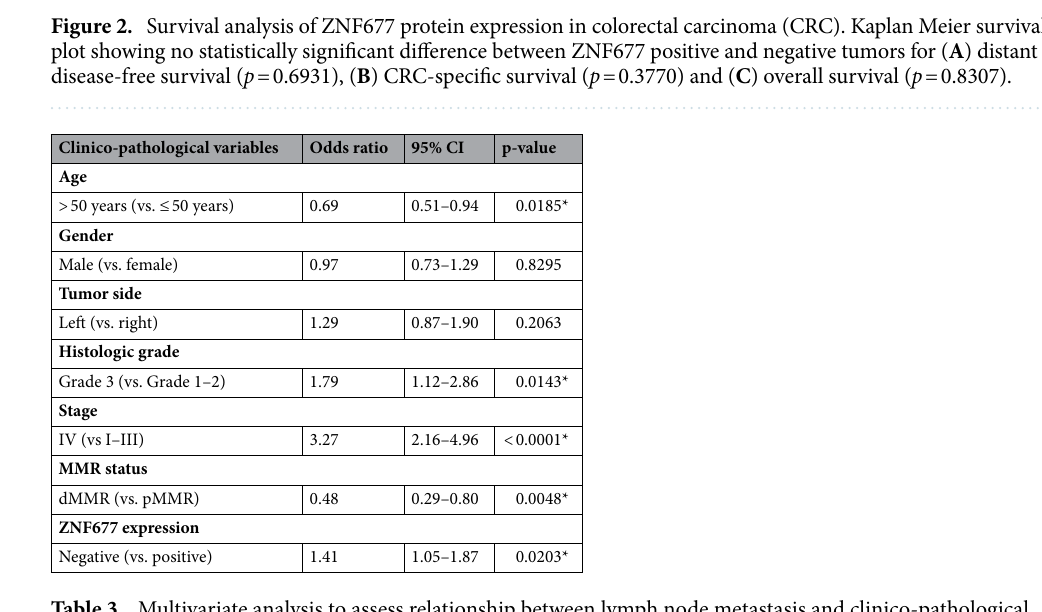
Table 3. Multivariate analysis to assess relationship between lymph node metastasis and clinico-pathological characteristics. *Significant p value.